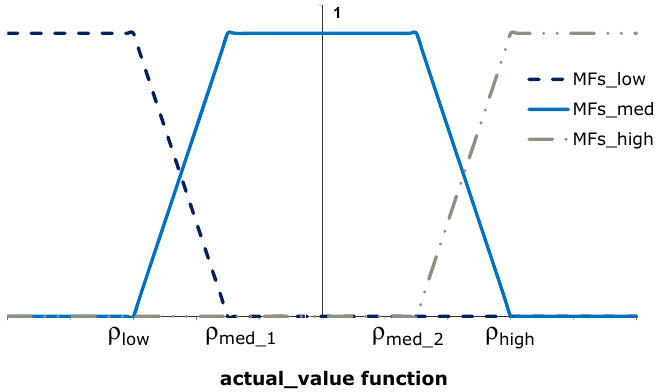
Figure 4. Trapezoidal membership functions (MFs).